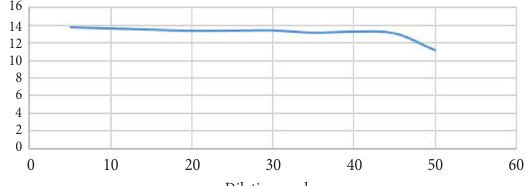
Fig. 13. The values of the objective function versus different eccentricities in dual-border cut test